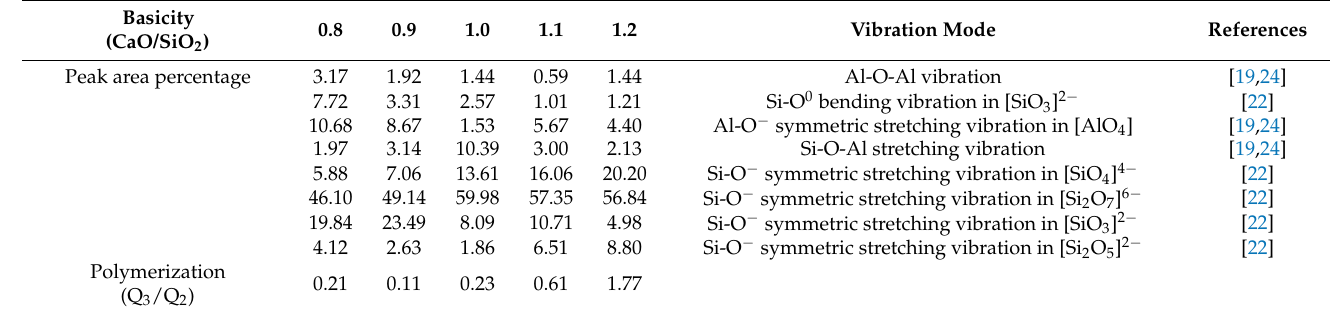
Table 5. Relative contents of the characteristic peaks of the glass phase with different R